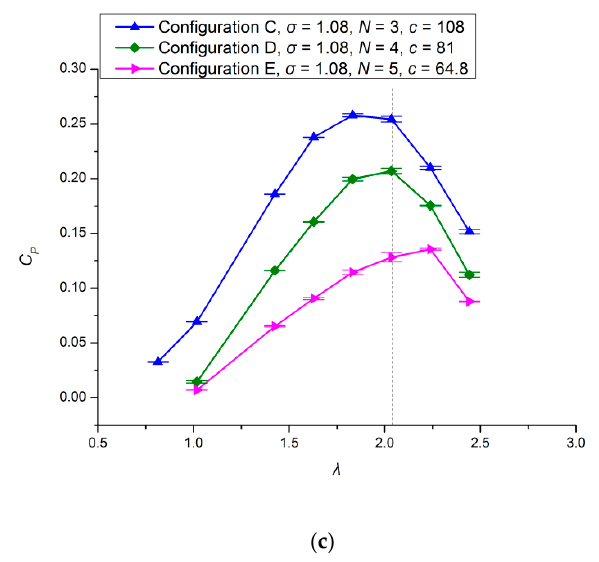
Figure 3. The power coefficient curves for ( a ) N = 3, ( b ) c = 81 mm, ( c ) σ = 1.08. Unsteadiness is also presented as error bars in curve